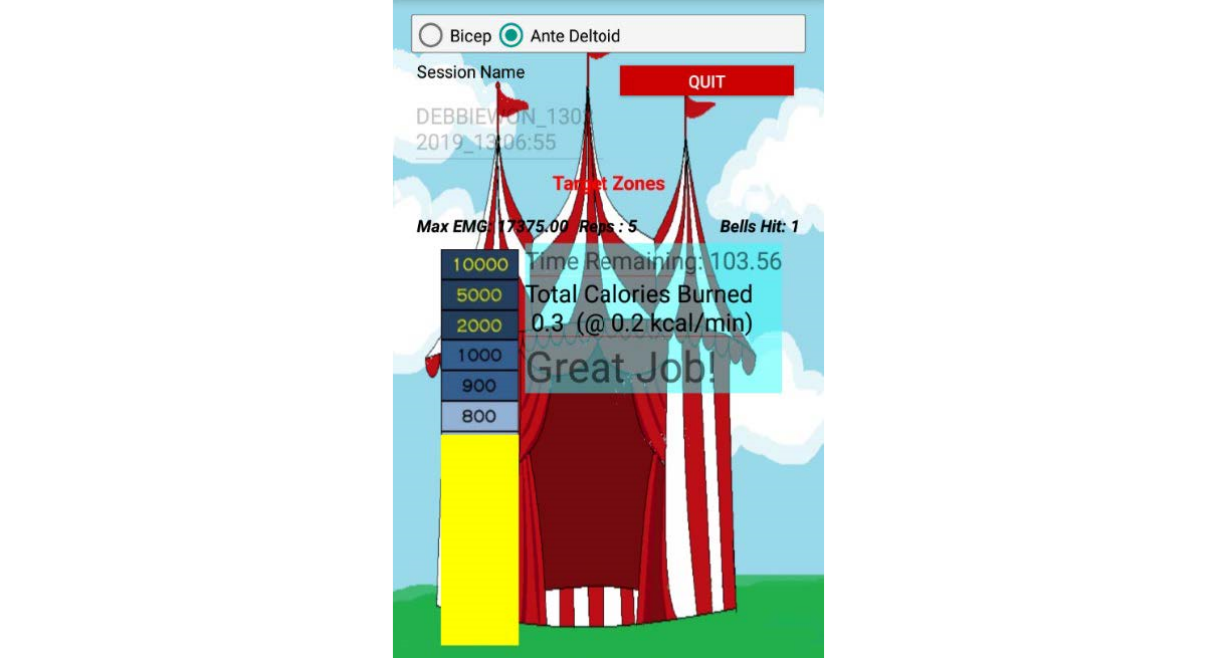
Figure 3. Screenshots showing the app interface for the high striker arm resistance band exergame. User selects which muscle to monitor. The ratio of the yellow bar height to the scaled background bar is equal to the iEMG: MVC level. (a) Interface during the middle of the game. Feedback also includes encouraging text, number of reps, and number of bells hit. (b) Interface at the end of the game, providing summary statistics and a prize based on the number of bells. iEMG: integrated electromyography; MVC: maximum voluntary